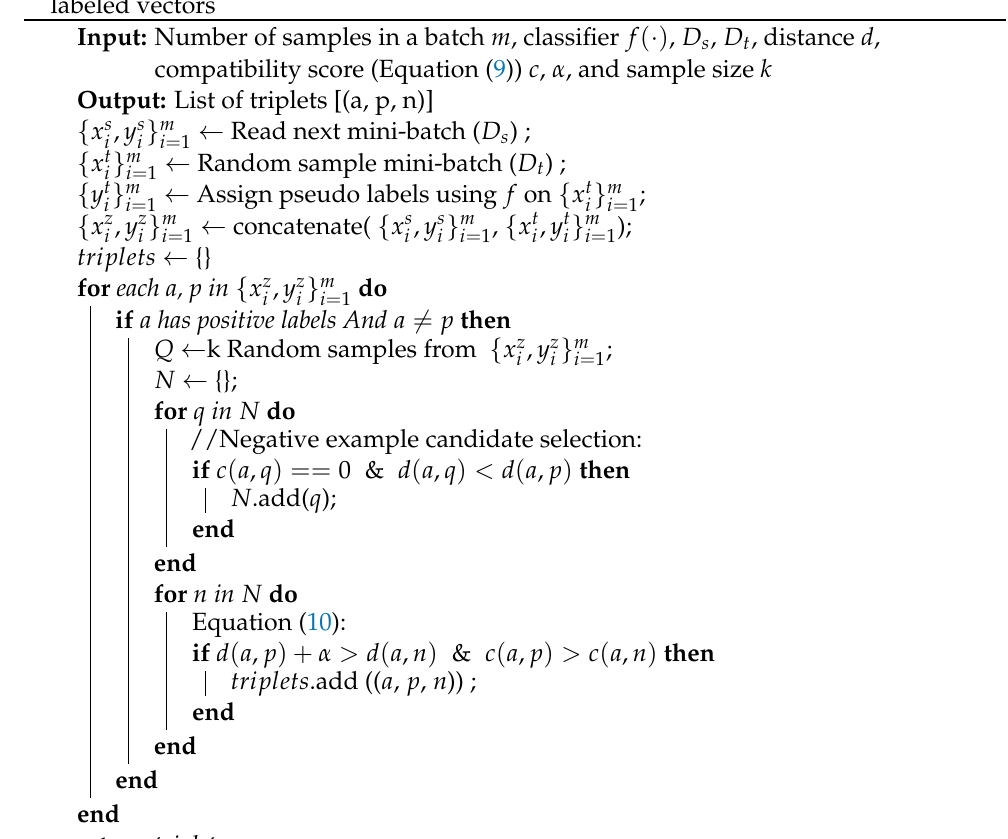
Algorithm 1: J OINT - FUSION ONLINE TRIPLET MINING finds triplets with multi- labeled